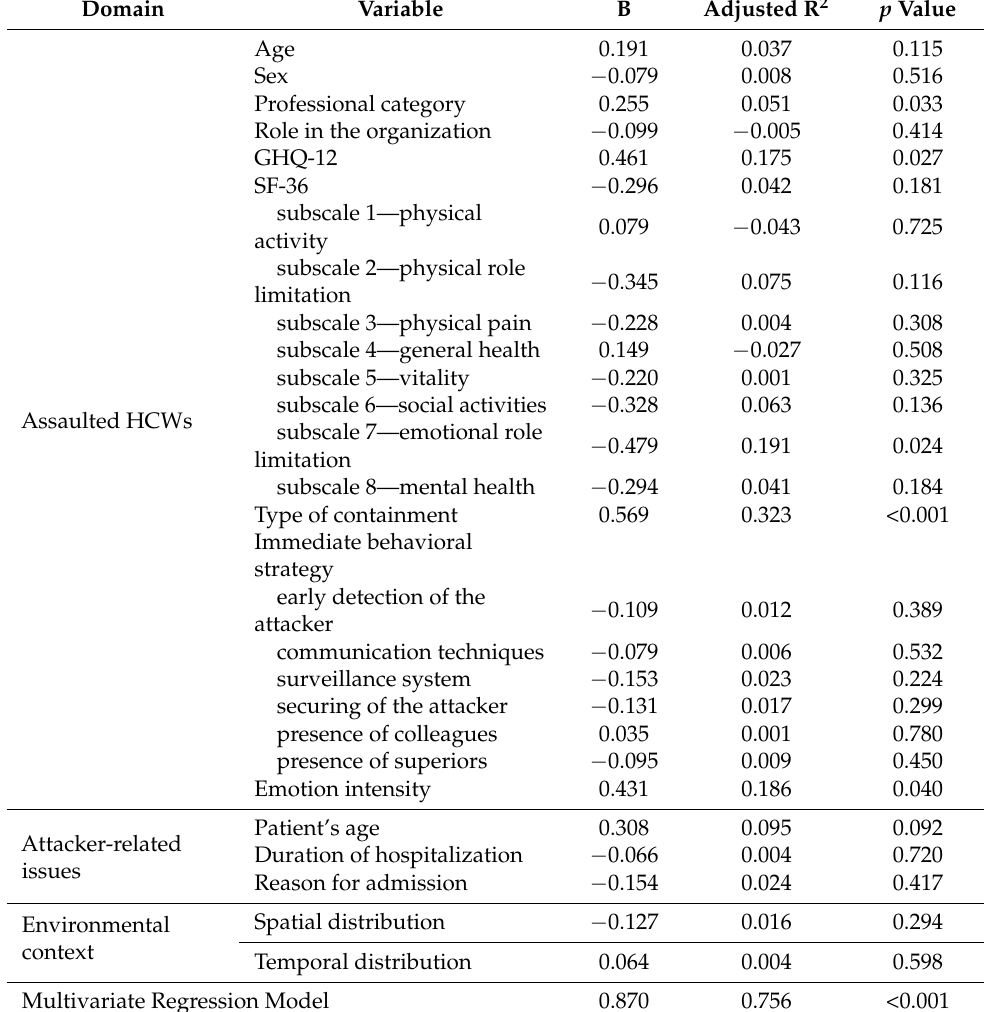
Table 6. Univariate analyses and multivariate regression